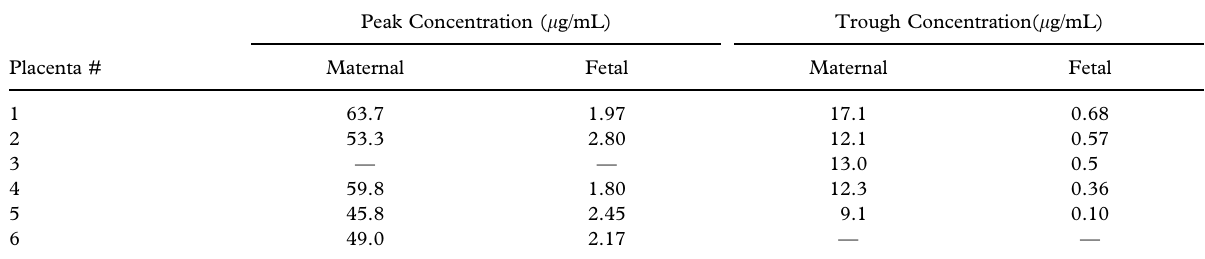
Table I. Meropenem concentrations.